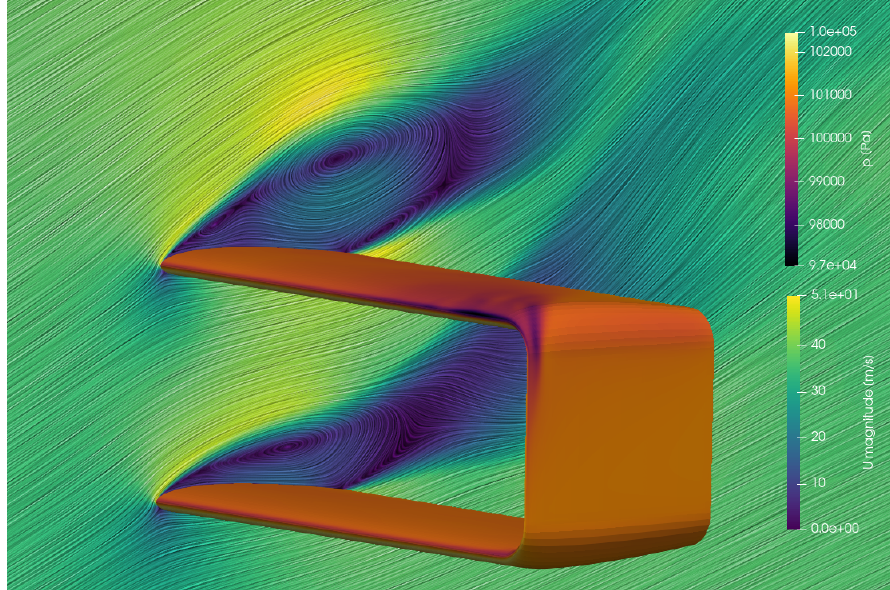
Figure 10. Pressure distribution on a box wing and velocity magnitude contour in the symmetry plane. The angle of attack of the wing is 21 ◦ , and the flow speed is 36.65 ms − 1 [35].